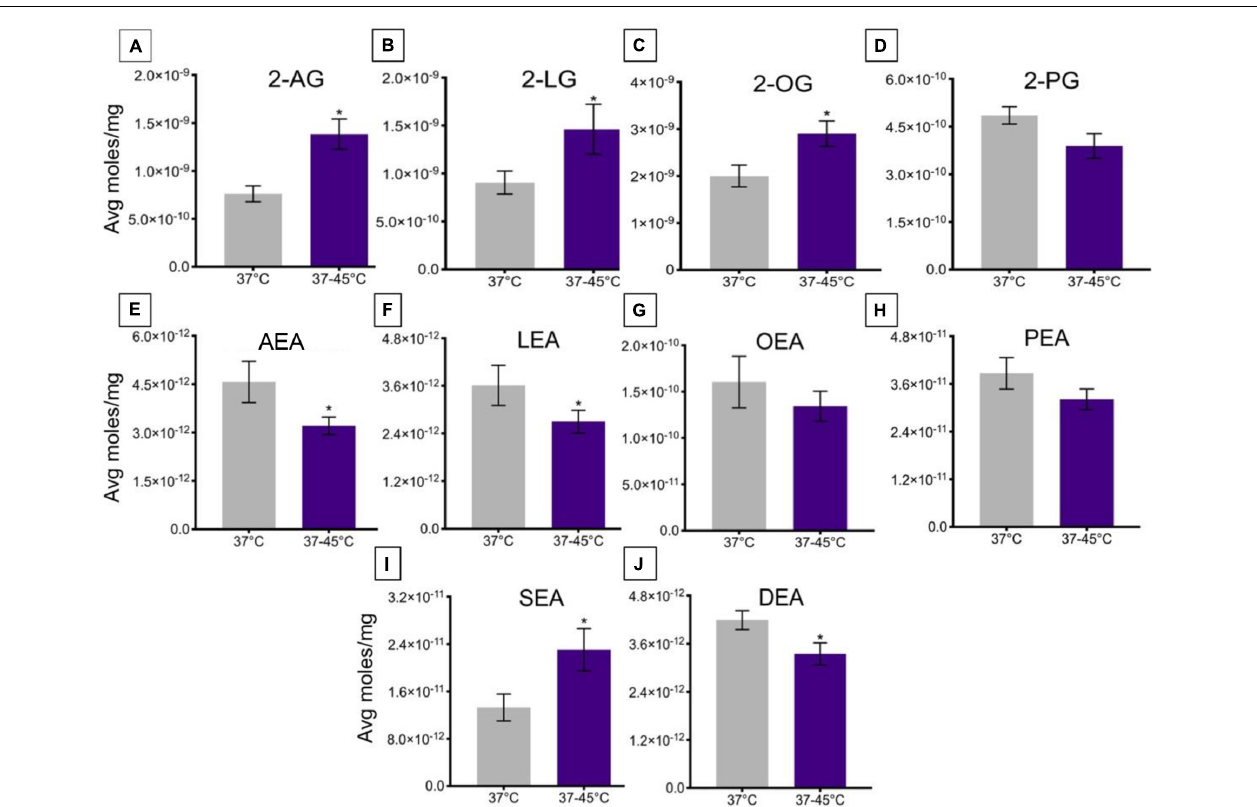
FIGURE 5 | Changes in lipid levels of 2-acyl glycerols (A–D) and N -acyl ethanolamines (E–J) upon an increase in temperature from 37 to 45 ◦ C. Significant temperature-induced changes after TRPV1-HEK293 cells were exposed to a change in ambient temperature from 37 to 45 ◦ C, is indicated by * ( p ≤ 0.05). Data depicted in each graph were averaged over 15 total data points per condition ( n = 3 individual experiments) and are presented as average moles/mg ( y -axis).